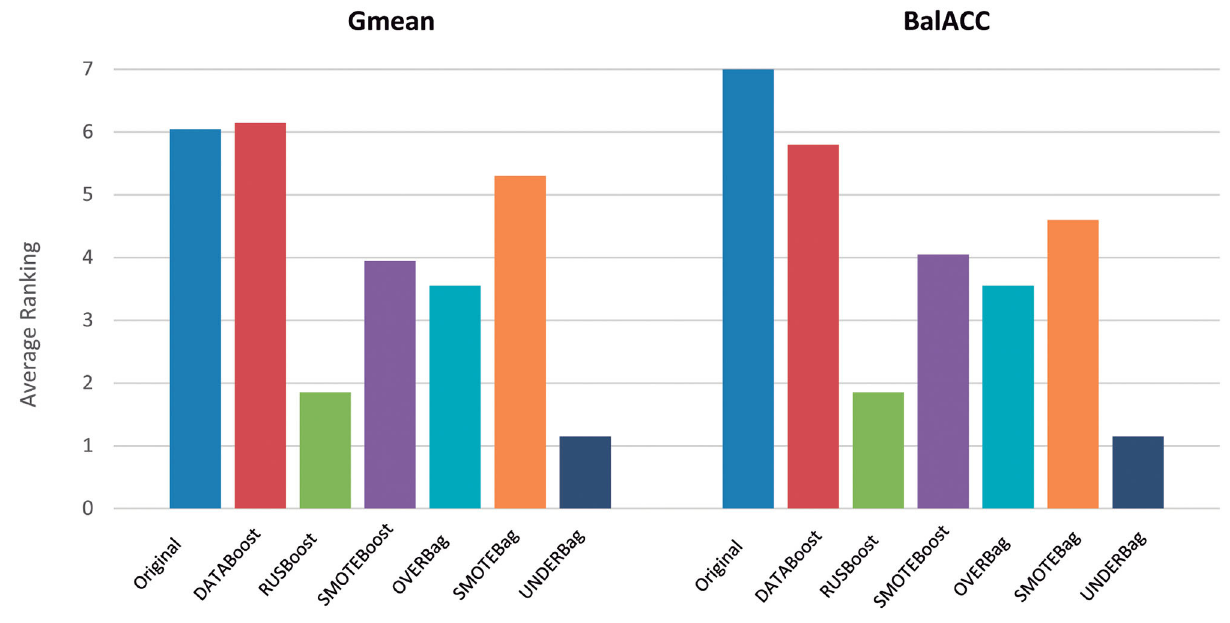
FIGURE 4 | Comparison of performances among the original dataset (blue bars) and six modified ensemble approaches for the imbalanced domain, in terms of the ranking ( y -axis) of Gmean and BalACC. Lower-ranking values indicate better performances. As shown in Table 4 , for the results of statistical